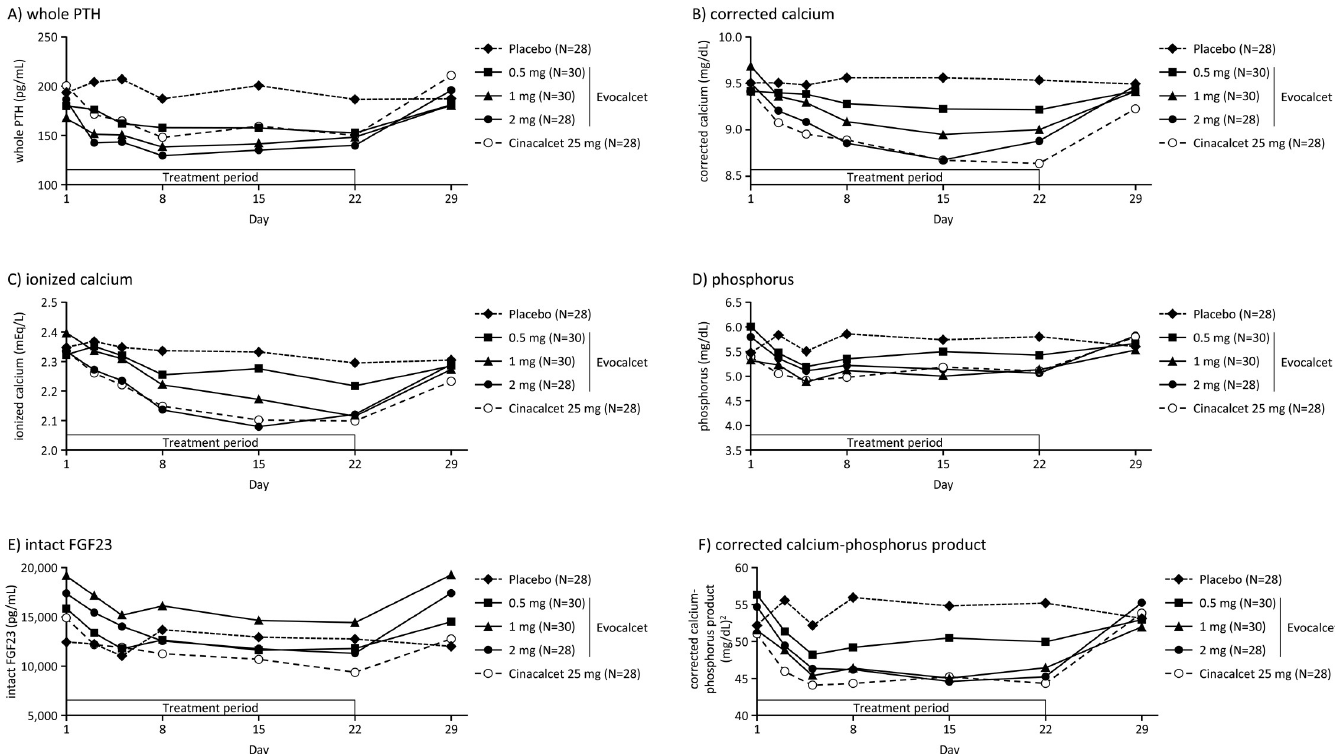
Fig 6. Time-course profiles of clinical laboratory variables (secondary endpoints). (A) whole PTH; (B) corrected calcium; (C) ionized calcium; (D) phosphorus; (E) intact FGF23; and (F) corrected calcium-phosphorus product. PTH, parathyroid hormone; FGF23, fibroblast growth factor 23.